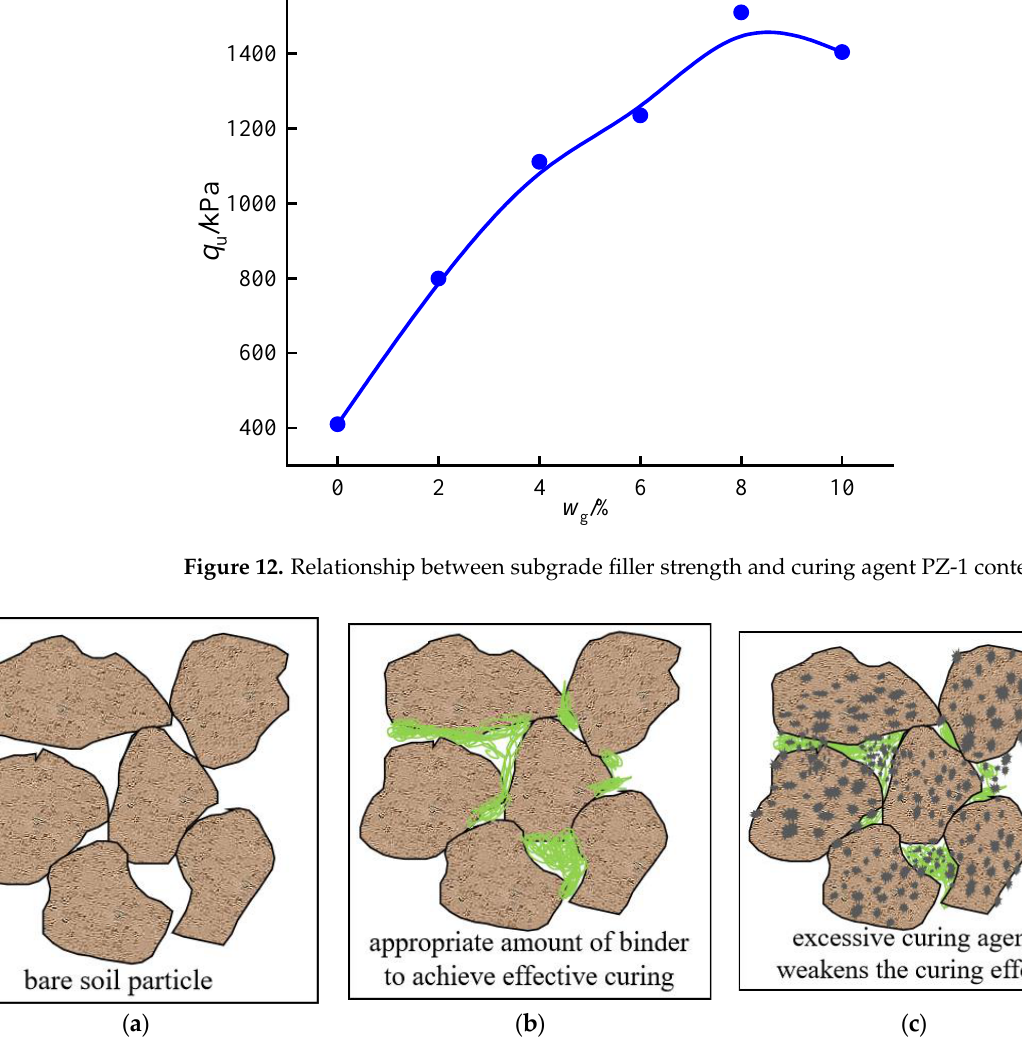
Figure 13. Mechanism diagram of remaining curing agent activity in soil: ( a ) before curing, ( b ) ap- propriate curing agent for curing, ( c ) excessive curing agent for curing.